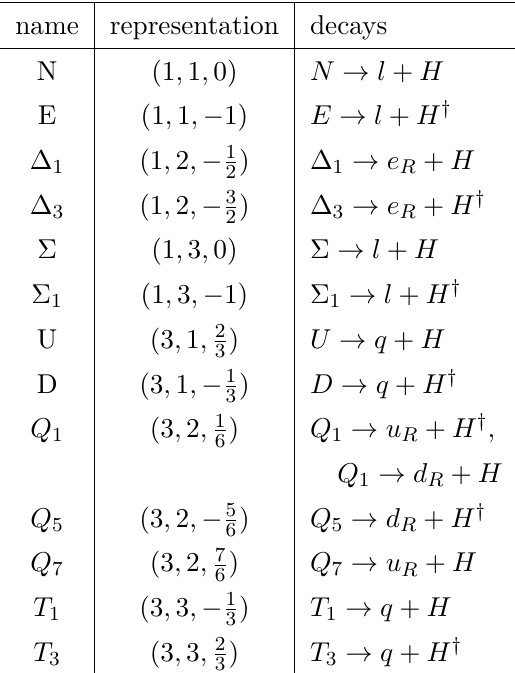
Table 8. Decay channels for fermion exits.